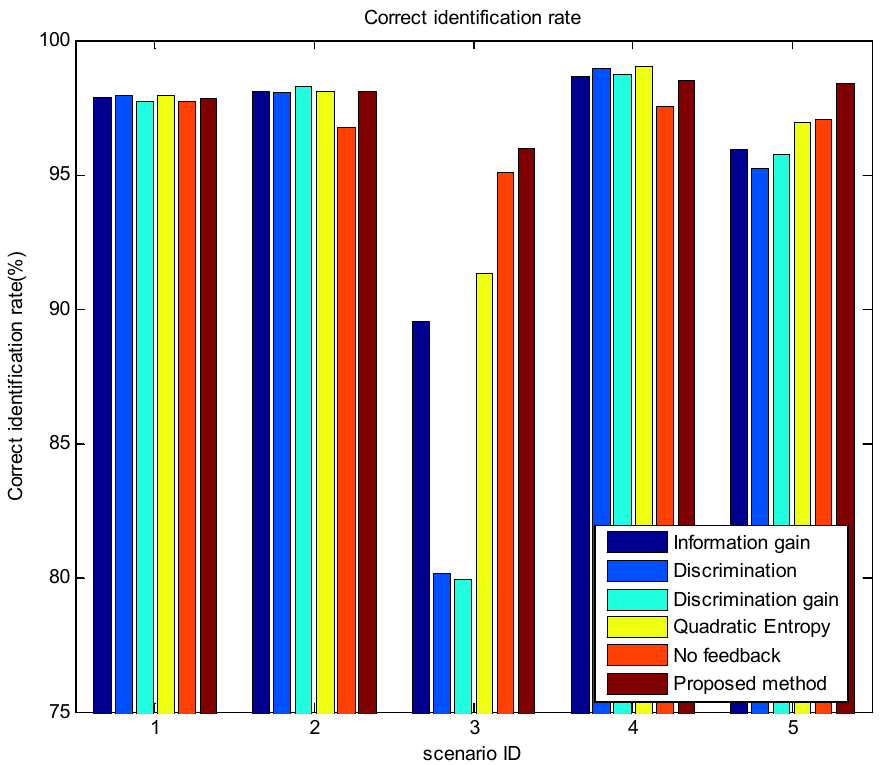
Figure 9. Sequence diagram of all target recognition accuracy rates in scenario 5 under condition 1.